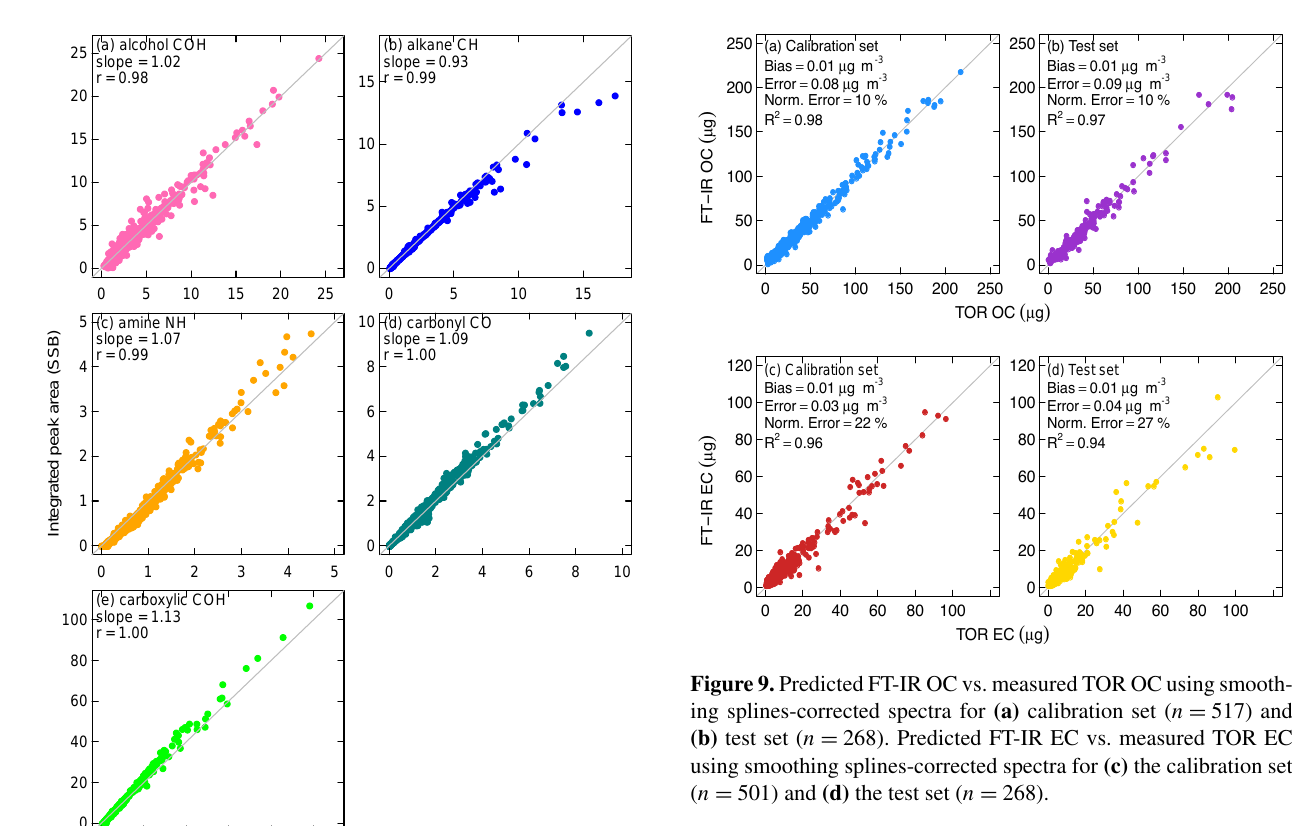
(d) carbonyl CO slope = 1.09 r = 1.00